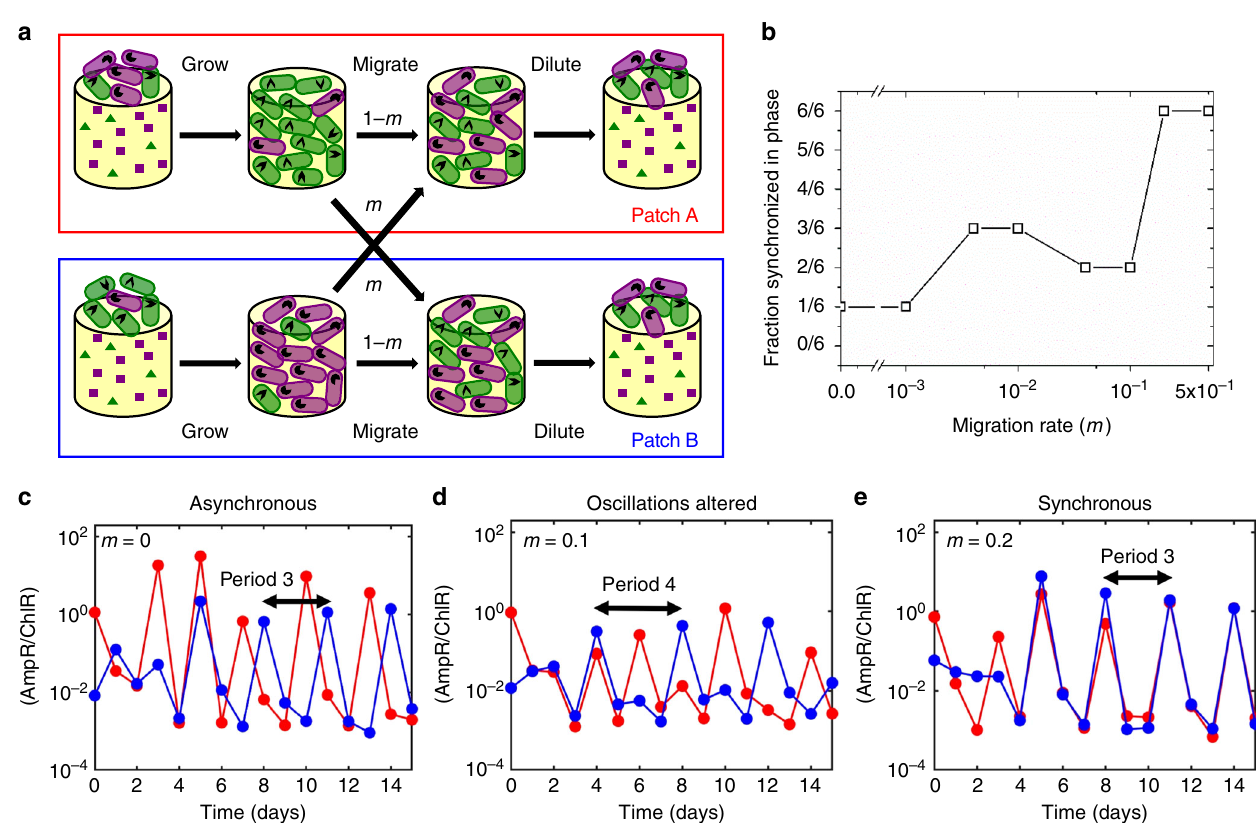
Fig. 3 Increased migration rate leads to altered population dynamics and ultimately to synchronization. a Schematic illustration of the growth-migration- dilution scheme employed in the experiments with two connected bacterial populations. The two patches A (red box) and B (blue box) correspond to two distinct co-cultures of AmpR and ChlR cells. The migration rate is denoted by m . b The fraction (out of six replicates) of connected pairs of co-cultures synchronized in phase as a function of the migration rate in benign environmental conditions. c – e Representative time series for the ratio of AmpR cells to ChlR cells in patches A (red data series) and B (blue data series) for m = 0 ( c ), m = 0.1 ( d ), and m = 0.2 ( e ), showing asynchronous period-3 oscillations, disturbed oscillations with various periods and synchronous period-3 oscillations, respectively. In b – e , the experimental condition corresponds to 10 μ g/ml of ampicillin and 8 μ g/ml of